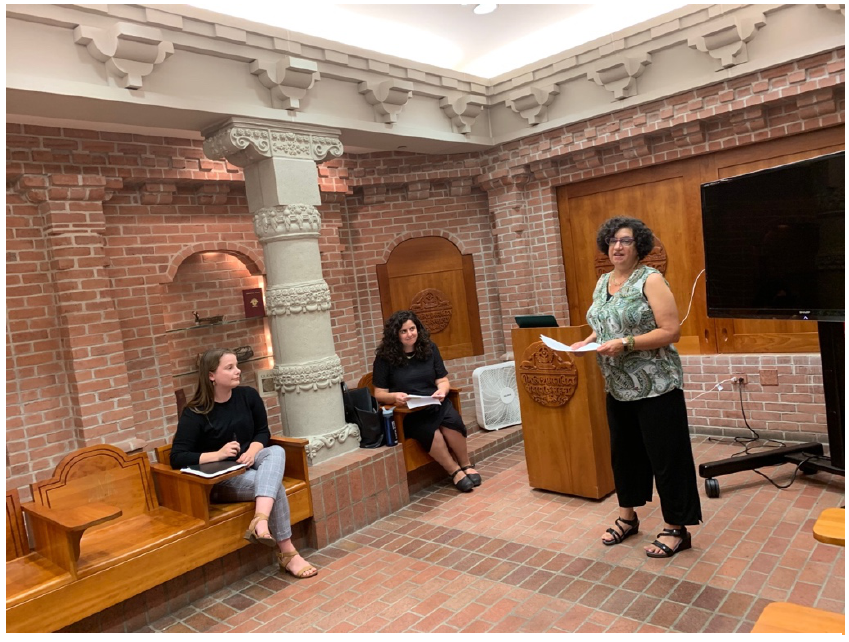
Photograph from “India in America:” A Curatorial Conversation on the Work and Practice of Lockwood de Forest and Ahmedabad Wood Carving Company, October 3, 2019. (Photo: Alex J.